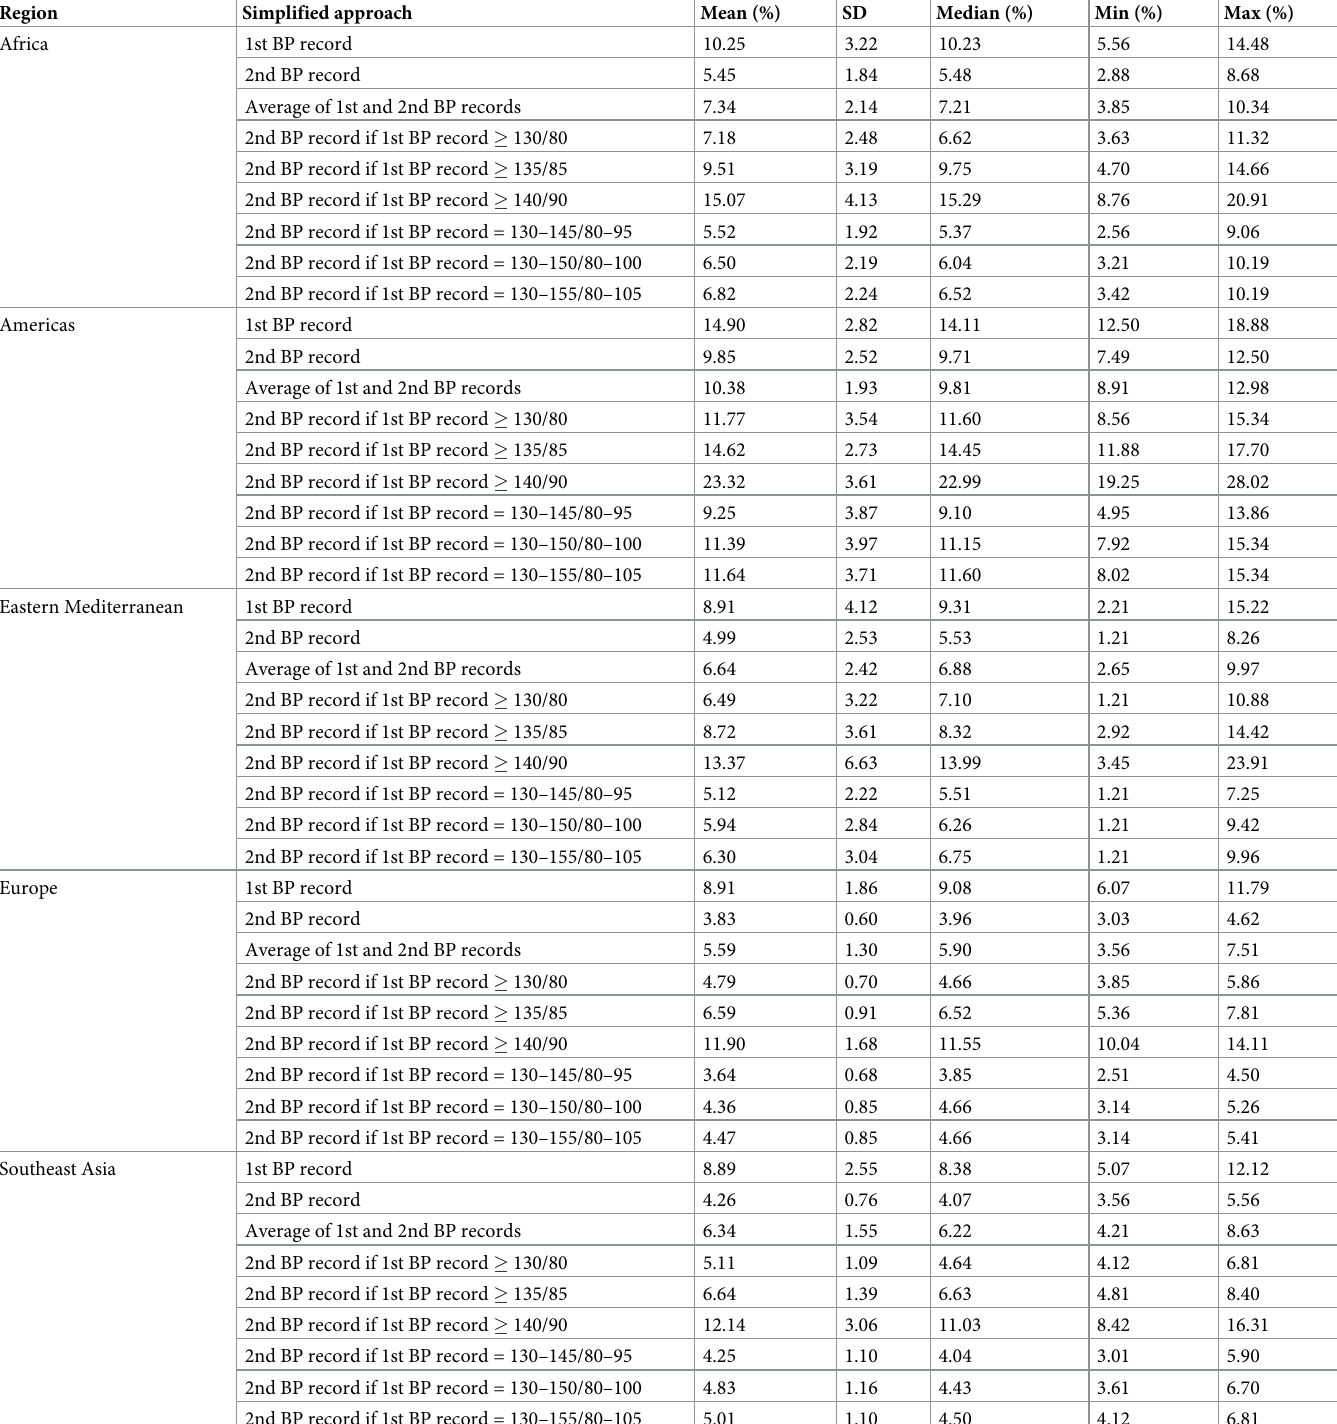
Table 3. Proportion (%) of missed hypertension cases for each of the 9 simplified approaches by WHO world region. Region